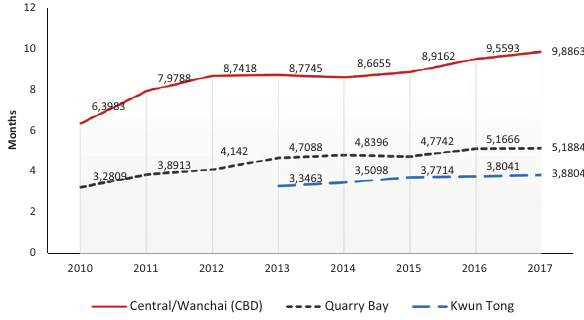
Figure 2. Green costs payback period (in